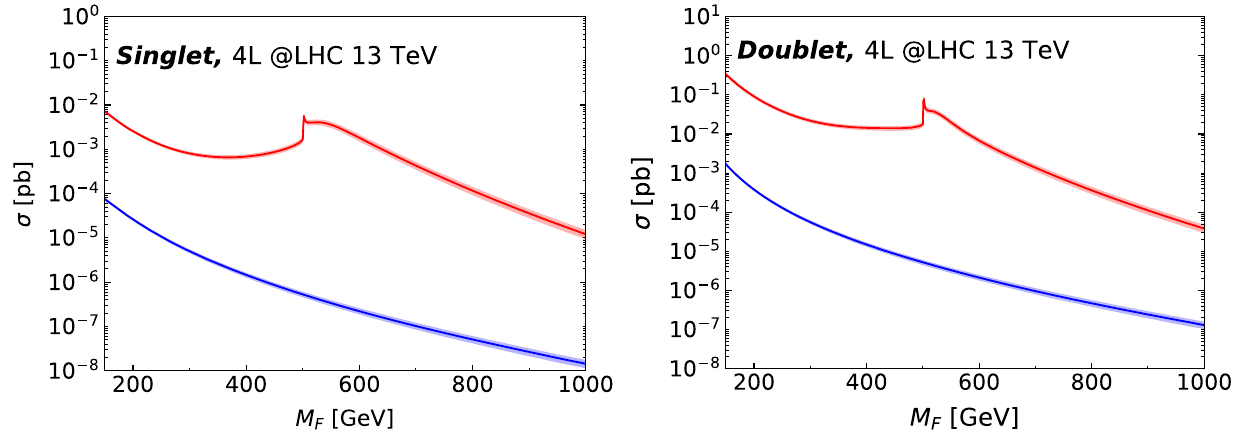
Fig. 5 Cross section for BSM production of at least four light leptons curves correspond to third-generation VLL models as in [23]. The band √ s = 13 TeV in the singlet (left) and the doublet at a pp collider with widths include uncertainties discussed in Sect. 4. The spikes in our VLL (right) model as a function of the VLL mass for M S = 500 GeV. The red curves correspond to the VLL models (2) and (4), while the blue